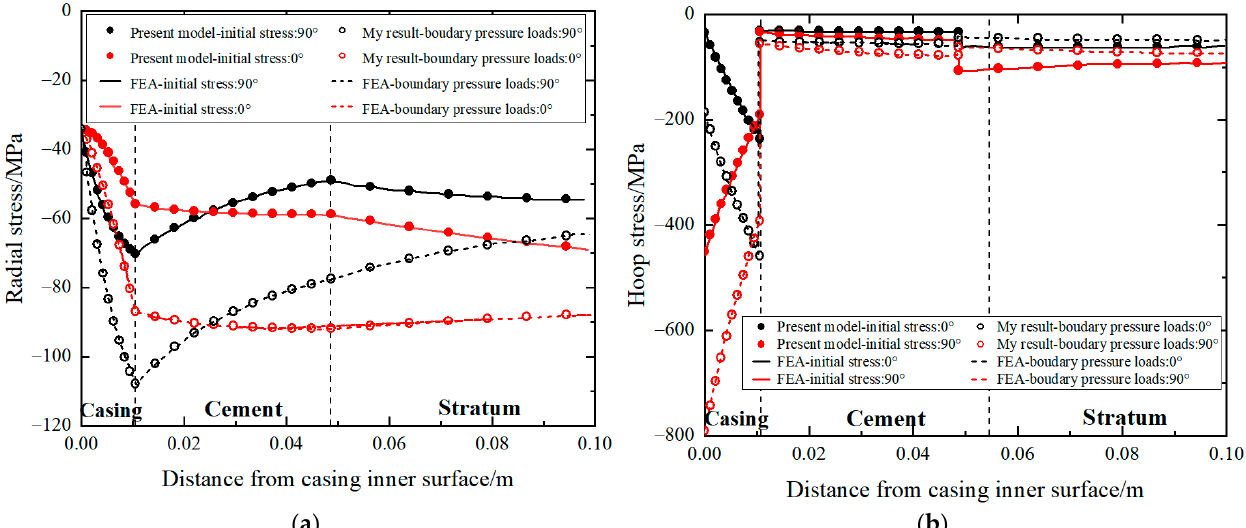
Figure 3. Comparisons of model results in Sub-problem I with existing model results and corresponding FEA [20] (Reproducted with permission from Liu W, Appl. Math. Mech ): ( a ) radial stress; ( b ) hoop stress. In addition, model results consider in-situ stress as boundary pressure loads, which coincide with corresponding FEA [20] and validate the accuracy of the analytical method. The input parameters are given in Table 1.